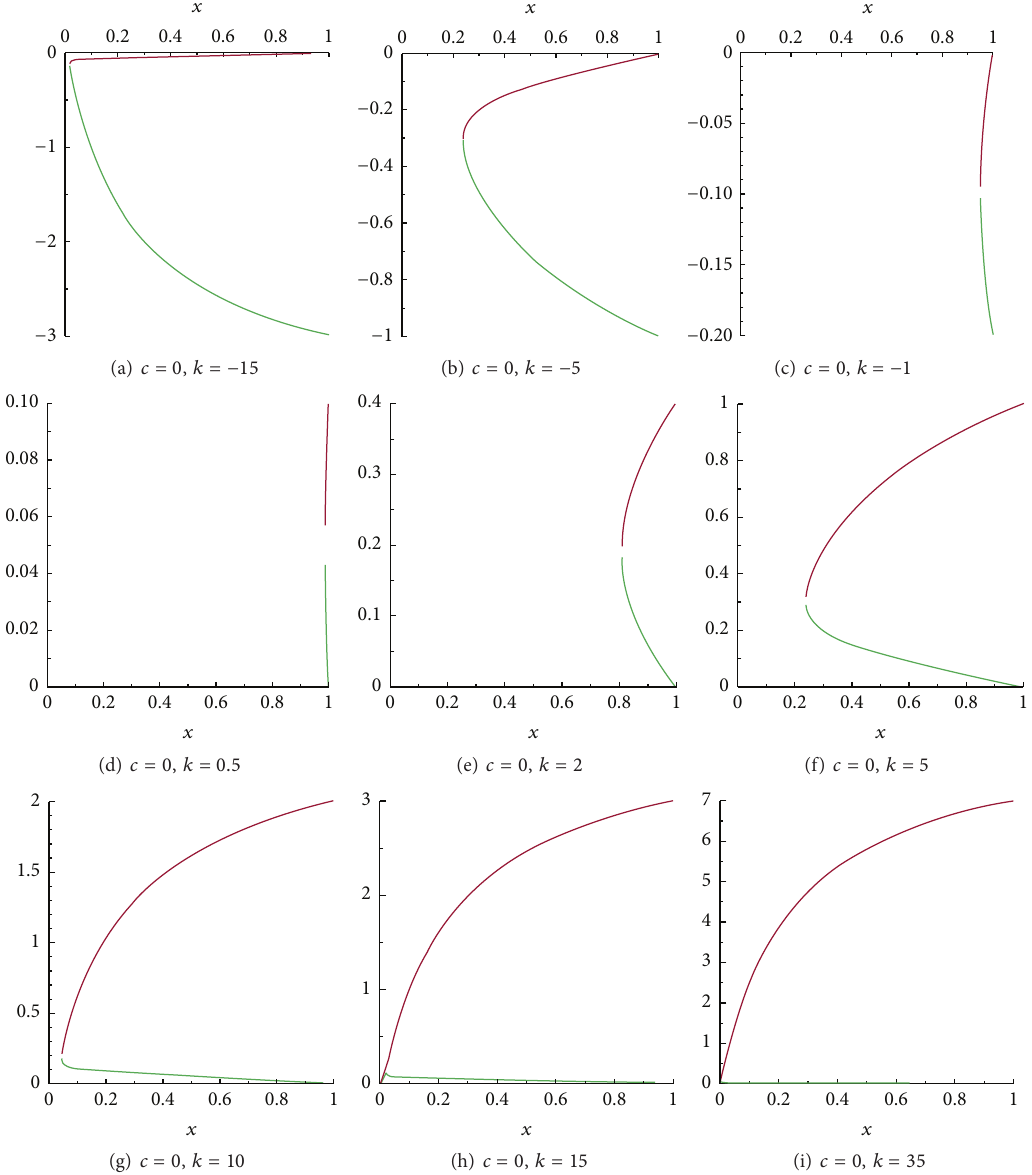
Figure 4: The branches of the vertical nullcline of system (27) for 𝑐 = 0 and several values of 𝑘 . Here 𝛽 = 2